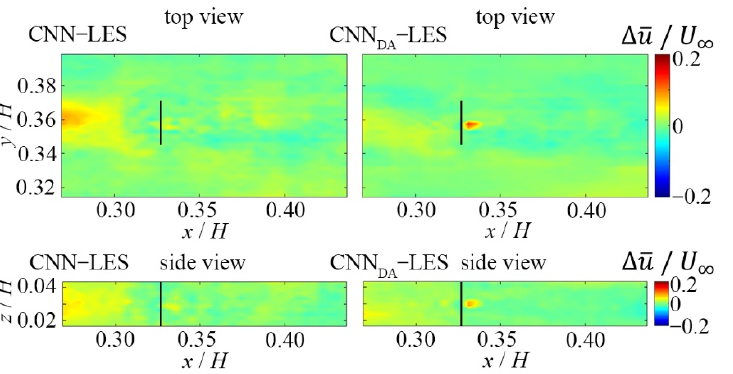
Figure 11. Contours of time-averaged velocity normalized with the free-flow velocity for wind turbines in the training case. Top view cross-sections are at hub-height and side-view cross-sections are at the rotor center. Contours are from the CNN, the CNN with data augmentation method (CNN DA ), and the LES results.